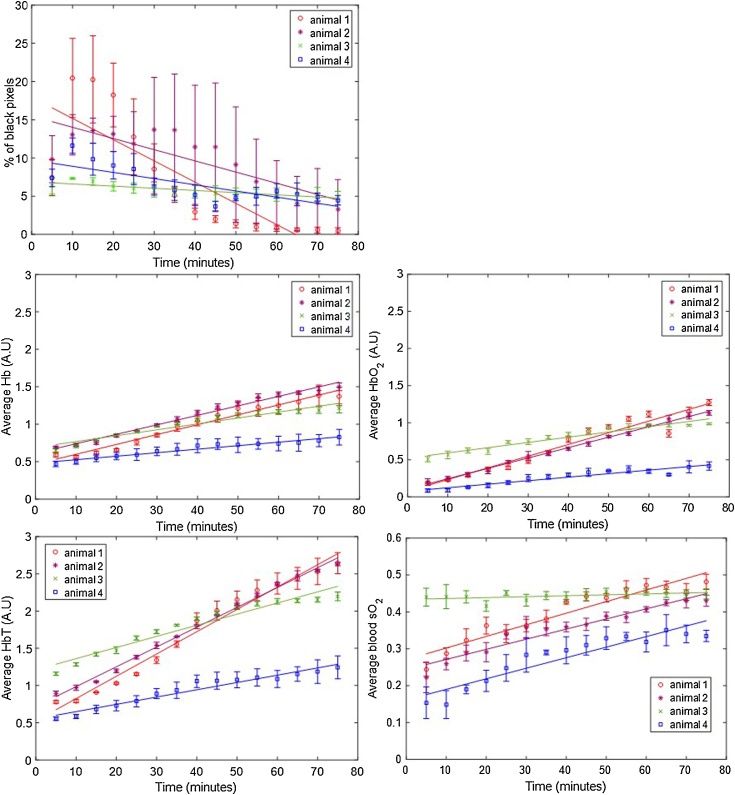
ROI-averaged percentage of black pixels, and Hb, HbO2, HbT and sO2 signals, for CALR tumours (n = 4) imaged over 75 min, during air-breathing. Error bars represent the standard deviation over 3 adjacent central tumour slices (ROIs), 1 mm apart. Solid lines represent a linear regression fitted to the data.